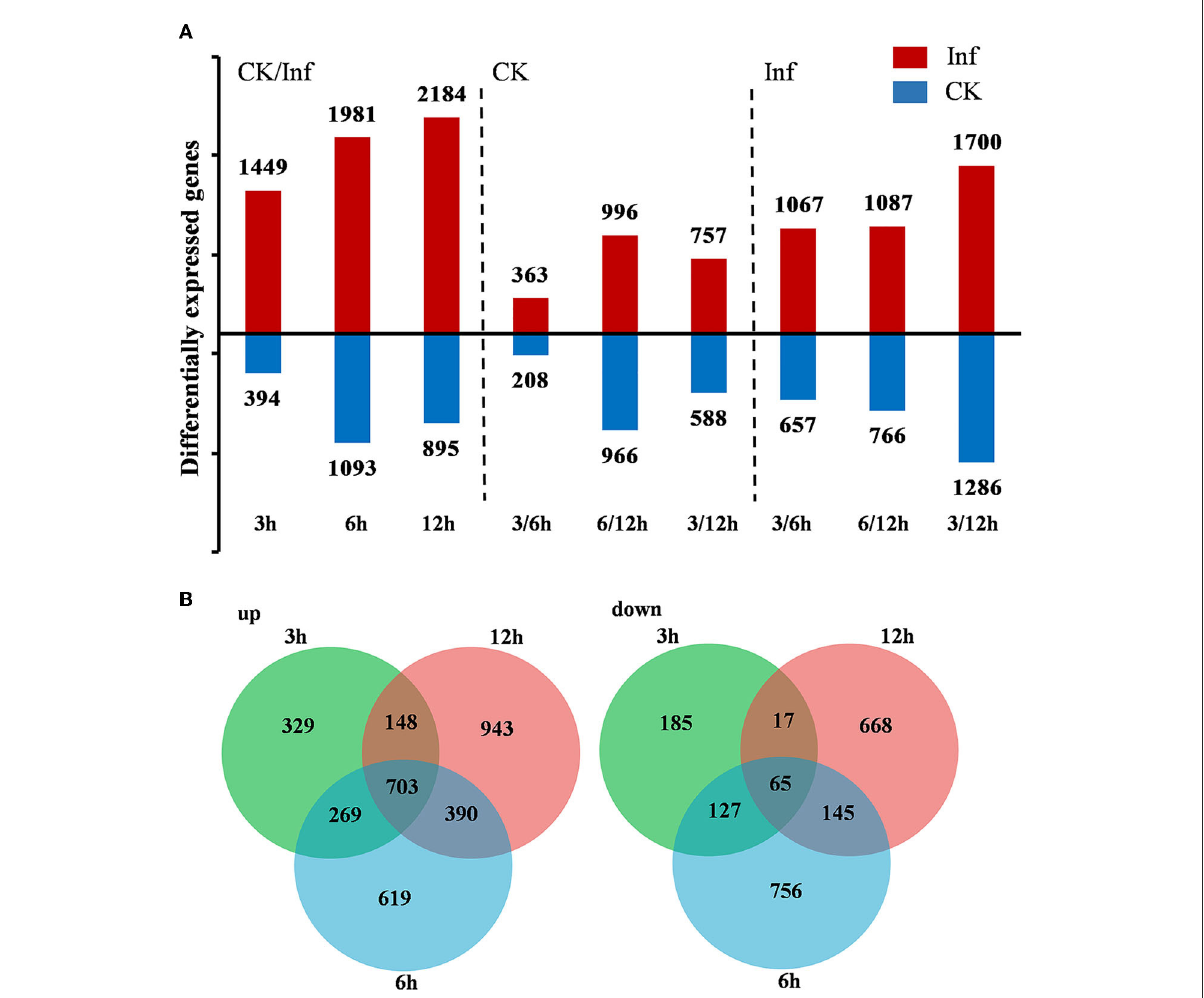
FIGURE3 Differentially expressed genes (DEGs) between the control (CK) and Ustilago maydis inoculated samples after 3, 6, and 12h, respectively. (A) Number of upregulated and downregulated genes after 3, 6, and 12h in control vs. infected samples. (B) Venn diagram showing the unique and shared DEGs in the treatment groups at 3, 6, and 12h, respectively. Plants infected with U. maydis (Inf) were analyzed at 3, 6, and 12 hpi respectively, using those injected with distilled water as control